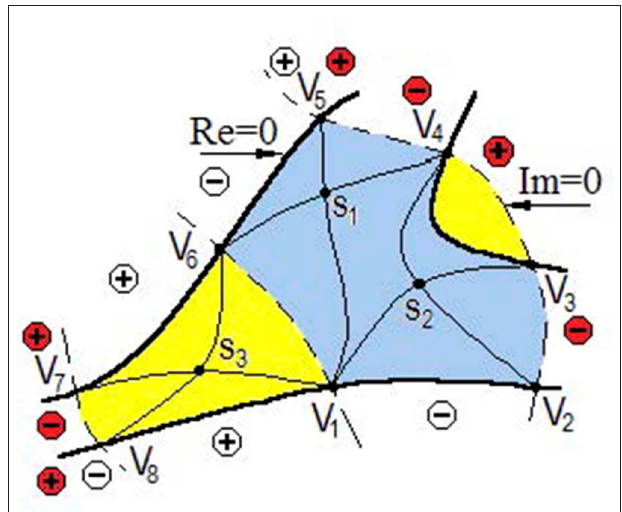
FIGURE 2 | The field fragment with three phase speckles [27]. The areas of the adjacent phase speckles are depicted by yellow and blue. The pluses and minuses in the circles correspond to the signs of Re u ( x , y ) (white circles) and Im u ( x , y ) (red circles) in this field